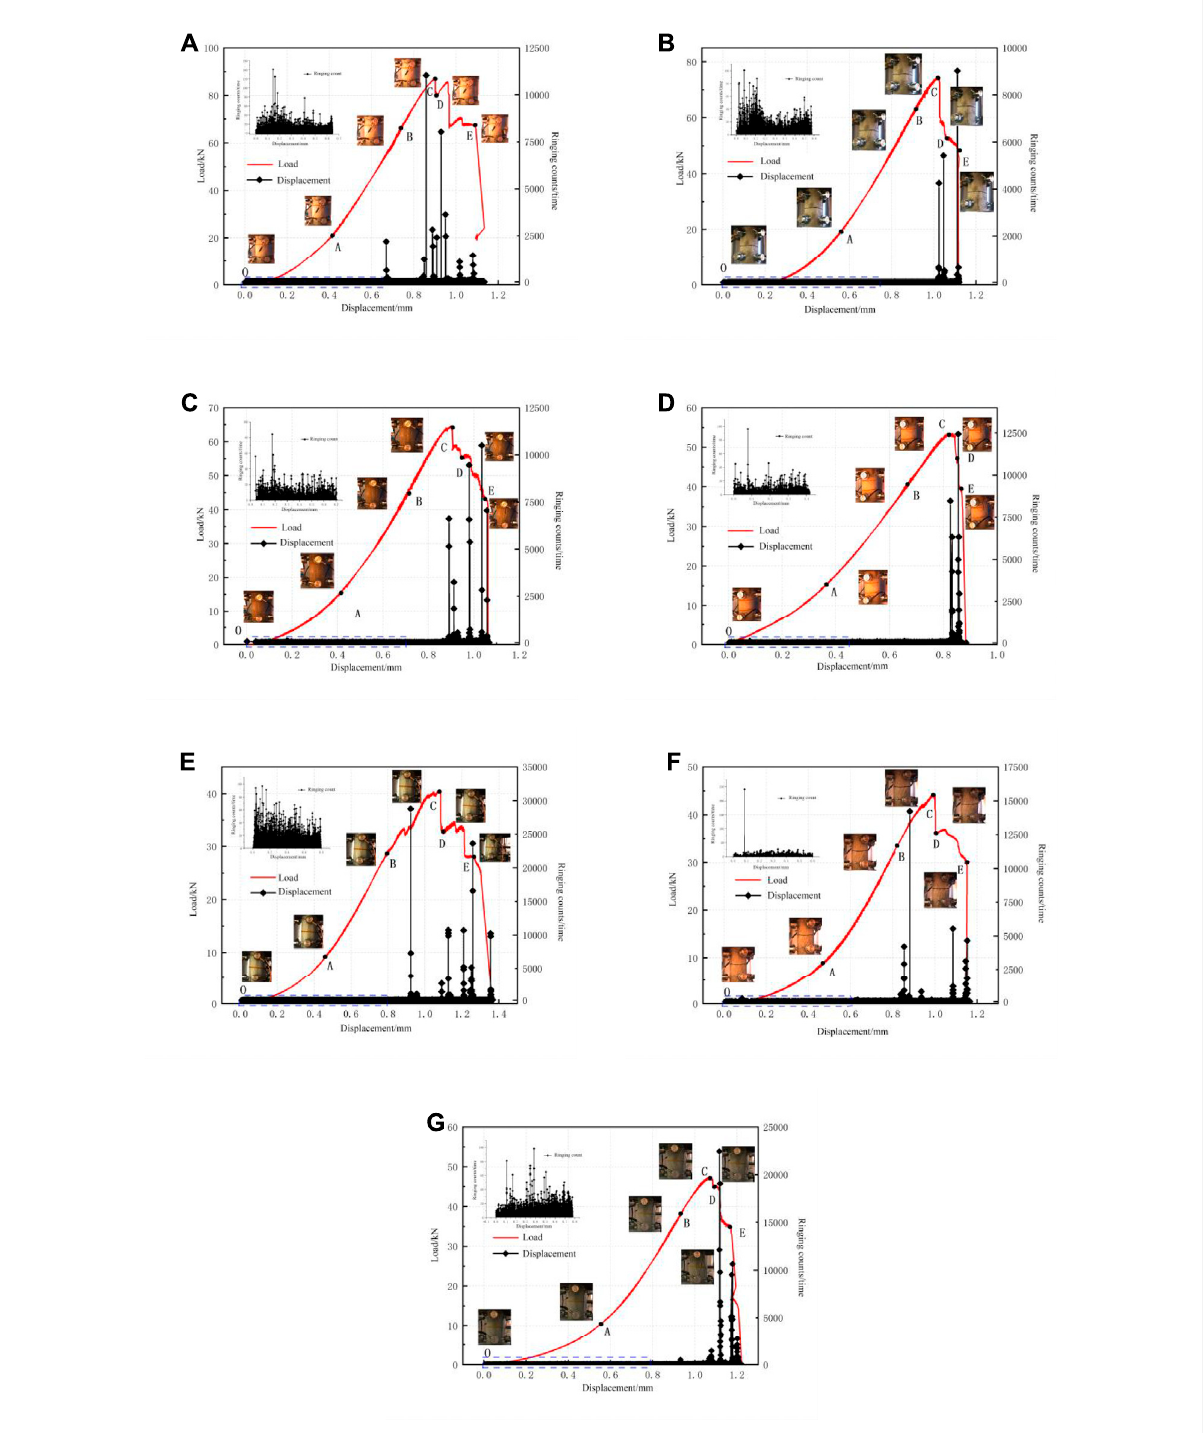
The acoustic emission (AE) signal of loading process: (A) 0%, (B) 30%, (C) 60%, (D) 75%, (E) 85%, (F) 95%, (G)